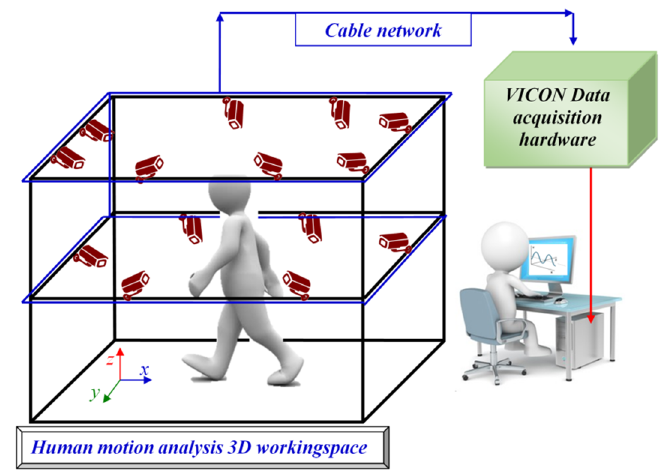
Figure 1. VICON equipment workflow for creating the proposed database.